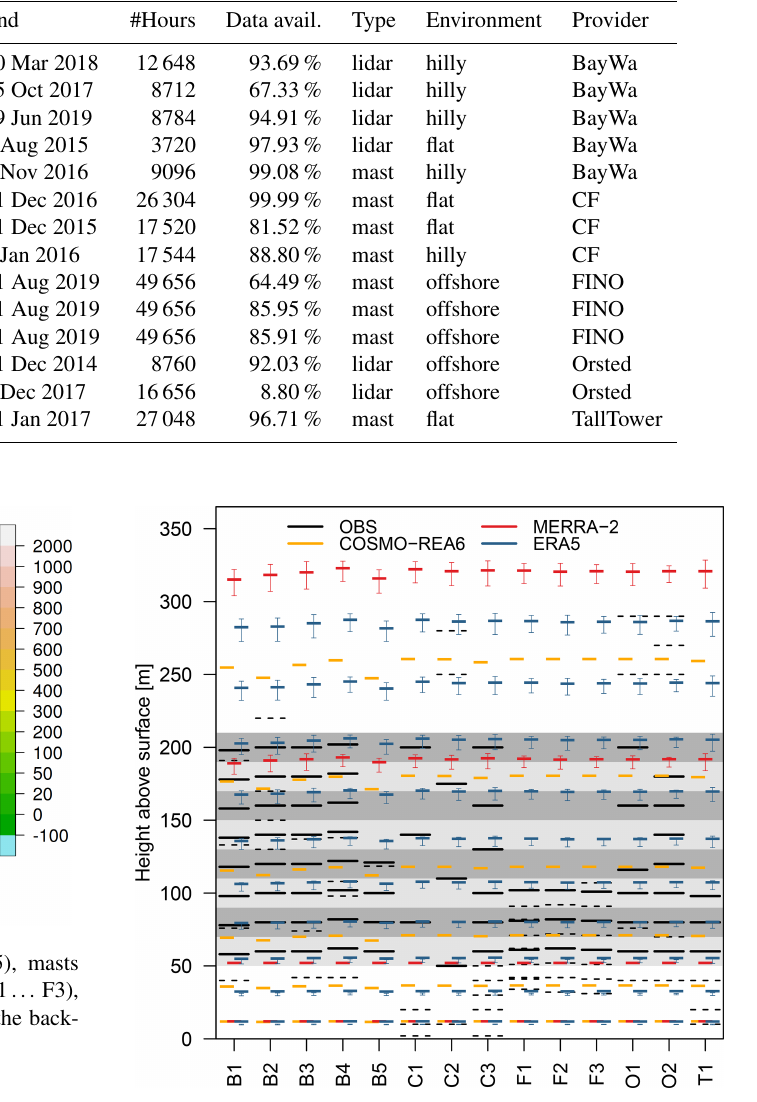
Figure 2. Observation heights (solid black) and output levels of COSMO-REA6 (orange), MERRA-2 (red) and ERA5 (blue) for all measurement sites. Grey shaded areas represent height ranges be- tween 50–70, 70–90,...,190–210m. Dashed black lines indicate observation heights which are not used in this study, because they are either below (above) 50m (210m) or further away from the cen- tre of a height range than an other observation. The vertically high- resolution observations B1 to B4 and O1 to O2 are from lidar mea- surements. Height of model levels in MERRA-2 and ERA5 depend on pressure, thus error bars indicate the standard